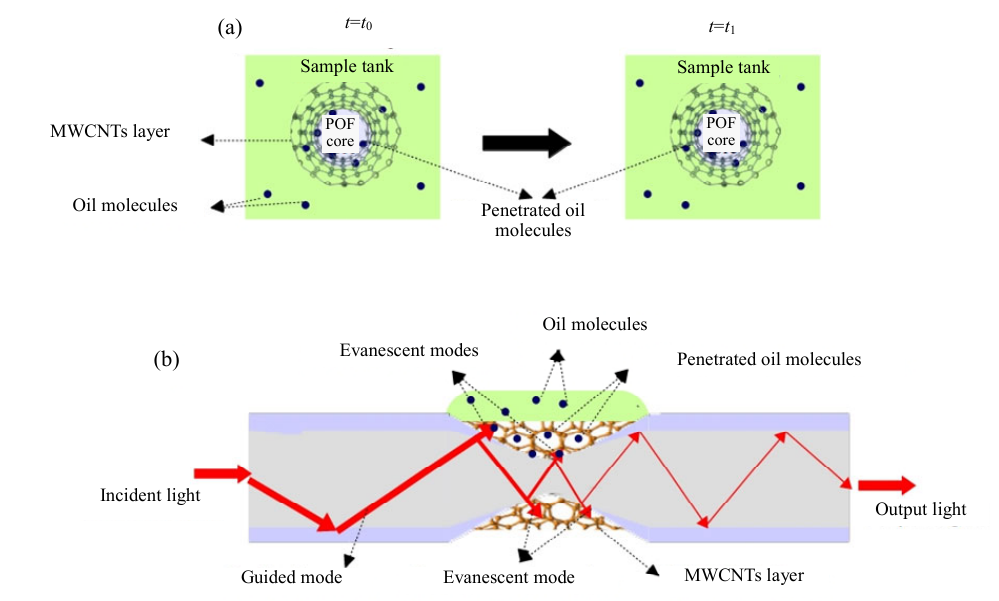
Fig. 8 Ilustration of (a) time evolution of oil molecules adsorption by the MWCNTs layer on the tapered POF and (b) schematic diagram of the mode propagation in the MWCNTs coated tapered